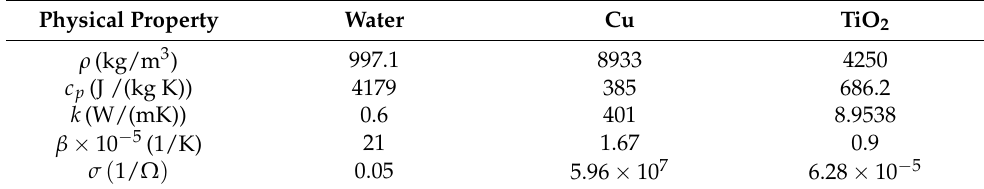
Figure 1. Configuration of the flow, problem geometry and coordinates. B = (cid:104) B 0 cos γ , B 0 sin γ ,0 (cid:105) . Table 1. Physical Properties of Water and Nanoparticles